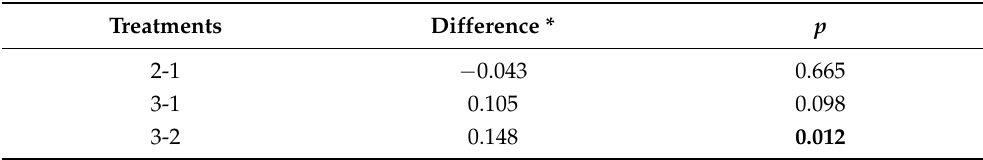
Table 5. Tukey HSD post hoc test results for enamel volume loss.